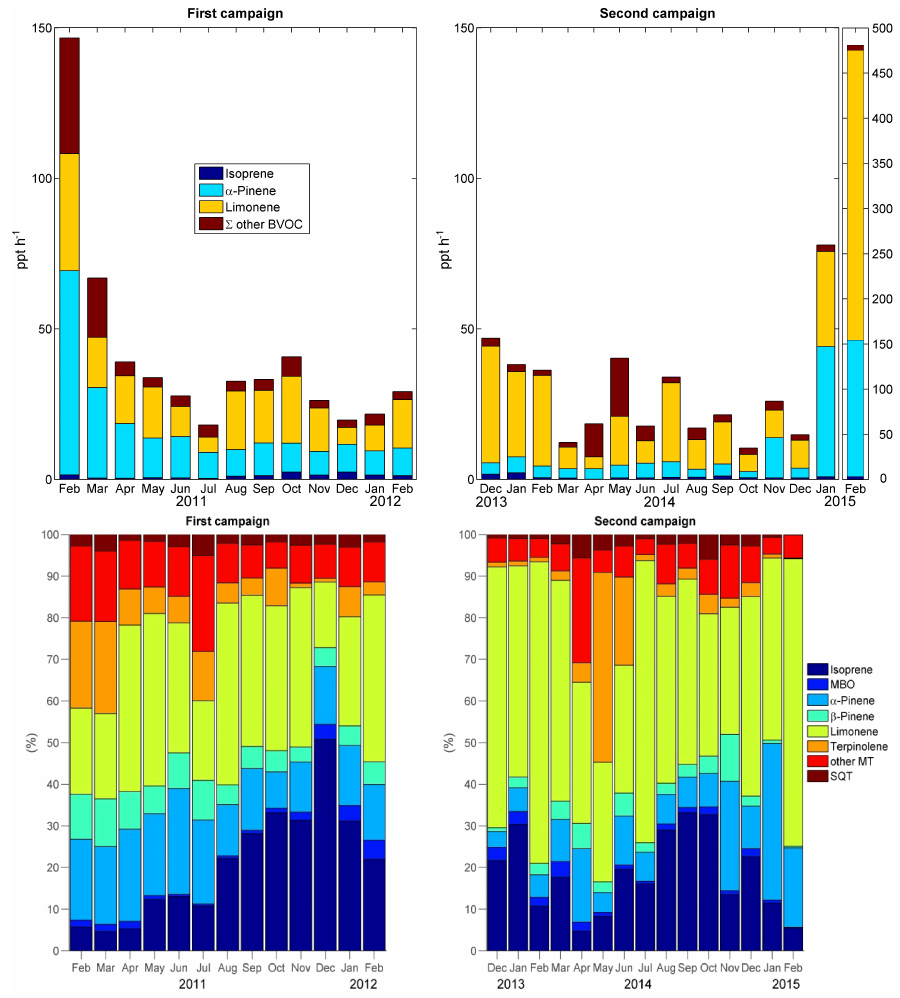
Figure 8. (a) Monthly means of reaction rates calculated for reactions between O 3 and BVOCs at Welgegund. A secondary axis is intro- duced for reaction rates calculated for February 2015 due to much higher reaction rates calculated for this month. (b) The relative monthly contribution of different BVOCs to the OH reactivity at